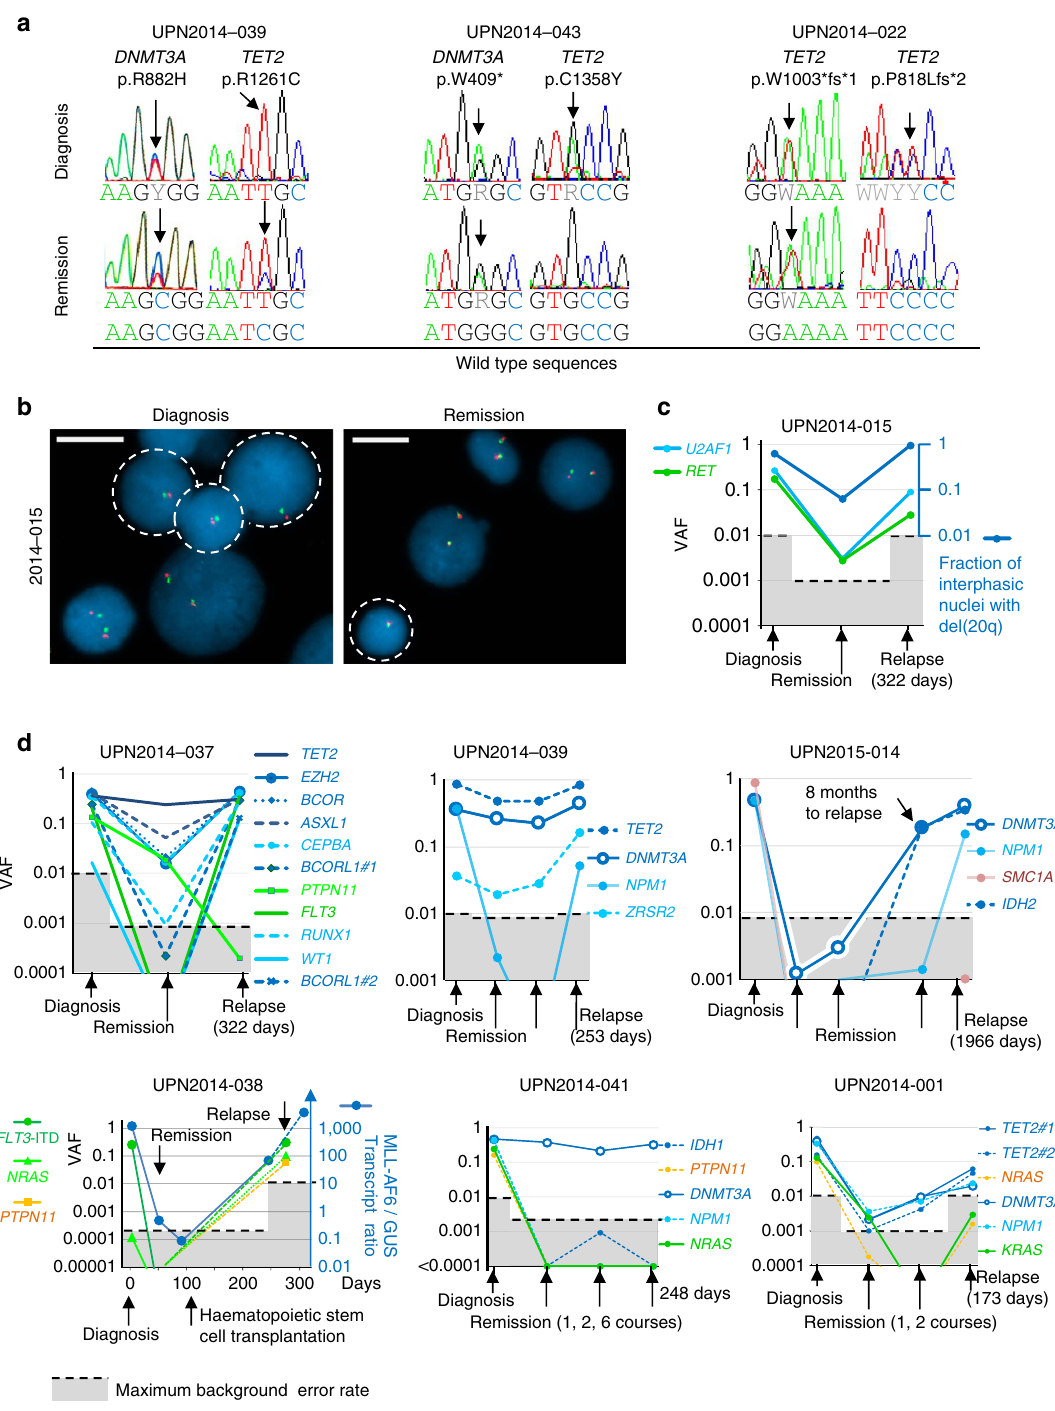
Figure 3 | Retention of lesions in remission samples defines reservoirs for persistent clonal haematopoiesis and relapse ( a ) Sequence traces of paired diagnostic and remission samples from three AML patients with DNMT3A and TET2 mutations. Arrows indicate the detection of mutant alleles. ( b ) FISH analysis of diagnosis and remission samples from patient UPN2014-015 with persistence of del(20q). Presence of one instead of two red þ green signals indicates del(20q)(outlined nuclei). Bars indicate 10 m m. ( c ) Kinetics of fraction of interphasic nuclei with del(20q) and VAFs of U2AF1 and RET mutations determined by targeted or deep sequencing in samples from patient UPN2014-015. Black dashed lines over shaded areas delimit the maximum background error rate for single nucleotide variant detection of patient specific mutations by deep sequencing, and the 0.01 limit of detection for the gene panel targeted sequencing. Different time points of follow-up are marked by arrows. ( d ) Kinetics of lesions in six additional patients as in ( c ). MLL-AF6 transcript quantification in patient UPN2014-038 was monitored by quantitative reverse transcription–PCR with a limit of detection of